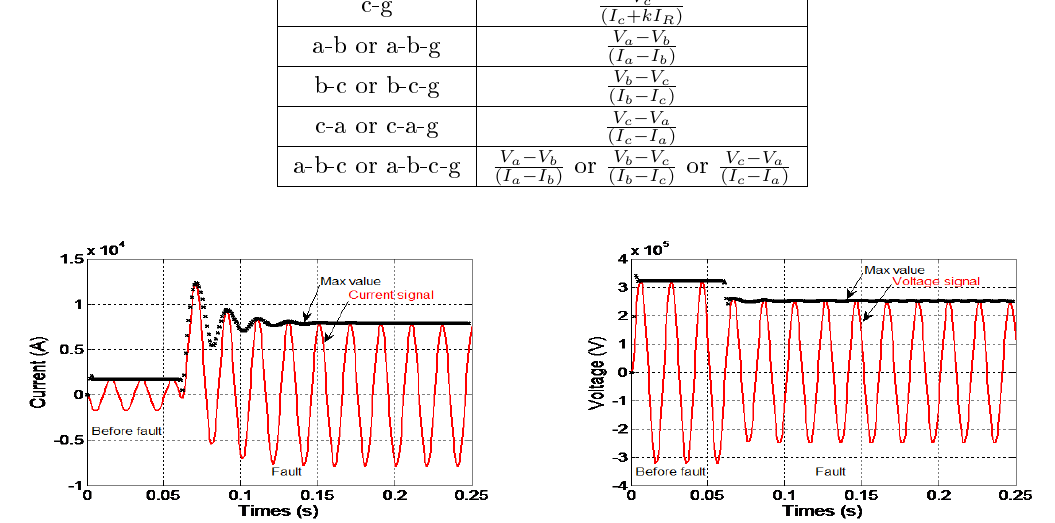
Table 1. Single fault impedance equation for negligible fault resistance.